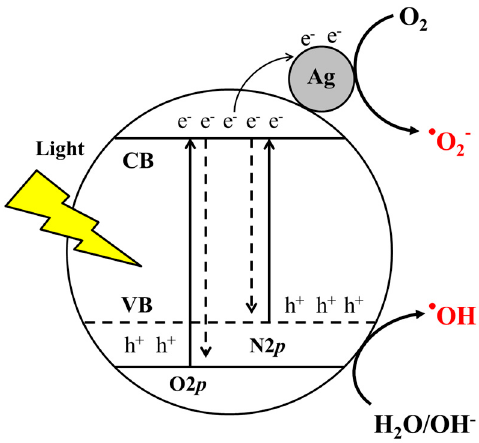
Figure 1. Photocatalytic reaction of Ag/N-TiO 2 .